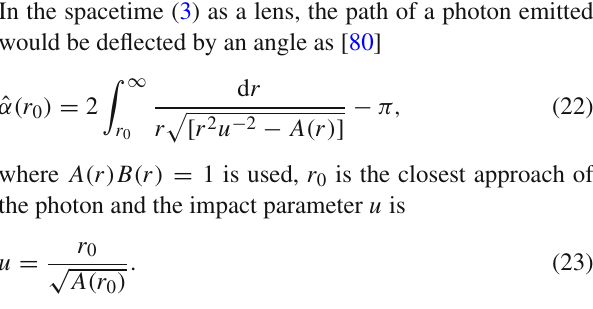
M87*’s shadow is consistent within 17% at 68% confidence level with the predicted size of the general relativity.